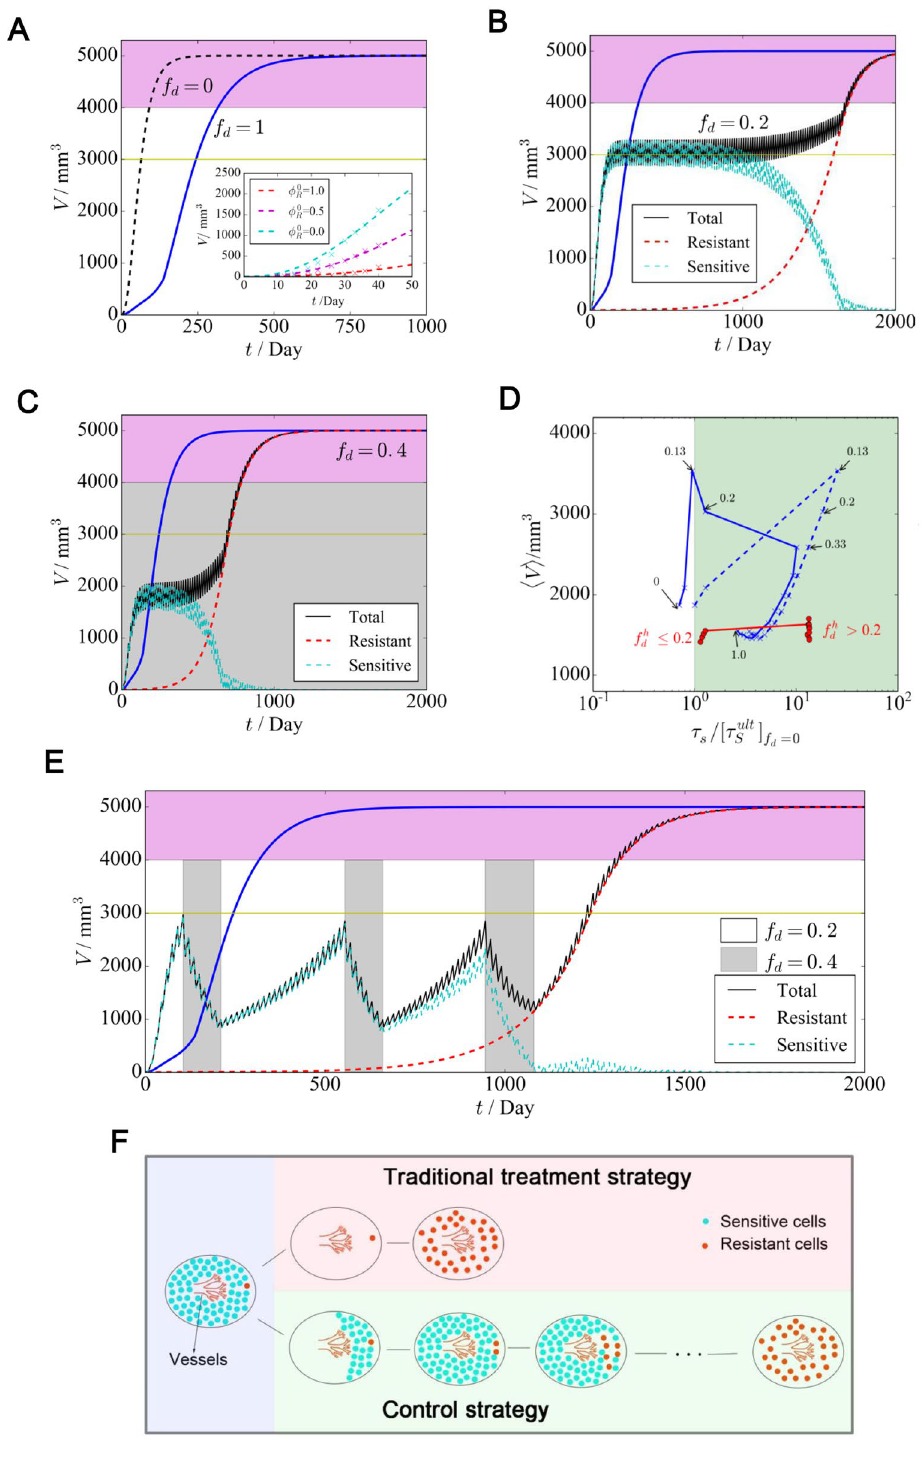
Figure 6. Model results of tumor growth and clinical treatment. ( A ) Tumor growth without dosing ( f d = 0) and with continuous high-dose therapy ( f d = 1). Inset: The mathematical model can model the tumor growth with different initial resistant cell fractions in drug-free cases. Here, the cross marks represented the growth of in vivo experiment (Fig. 4C) and the dashed lines represented the results of our mathematical model. ( B and C ) Tumor growth with different dosing frequencies. The blue line represents the traditional treatment strategy ( f d = 1). ( D ). For different fixed dosing frequencies, the scatter plot of the average tumor burden 〈 V 〉 , τ Sult (blue dashed line) and τ Sexp (blue line) in comparison with the survival time of continuous dosing τ adaptive therapy strategies with a varied dosing frequency, V and τ Sexp are marked with red dots. ( E ) Tumor growth under a varied dosing frequency. ( F ) Illustration of the traditional cure strategy and our control